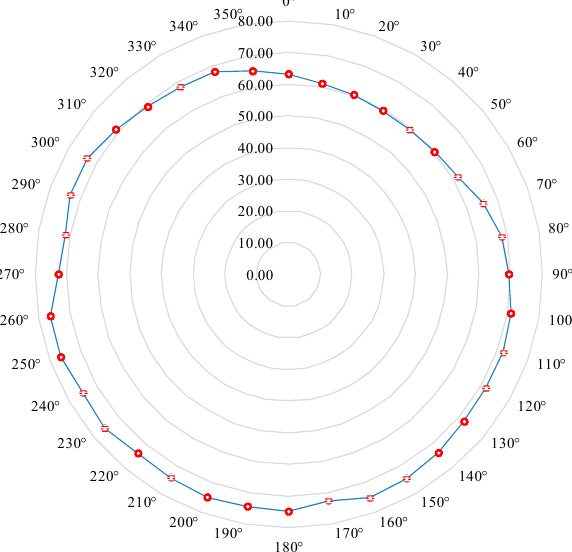
Figure 7. Absorbed power at the pumping station for the different angular positions of the lateral line.